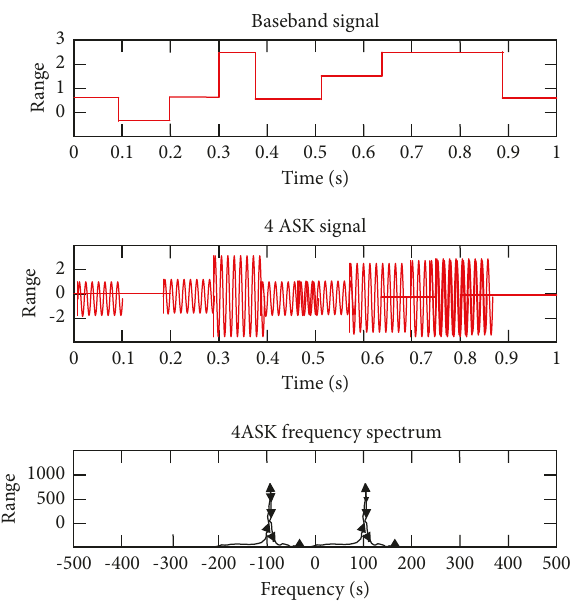
Figure 2: 4ASK time-domain waveform and